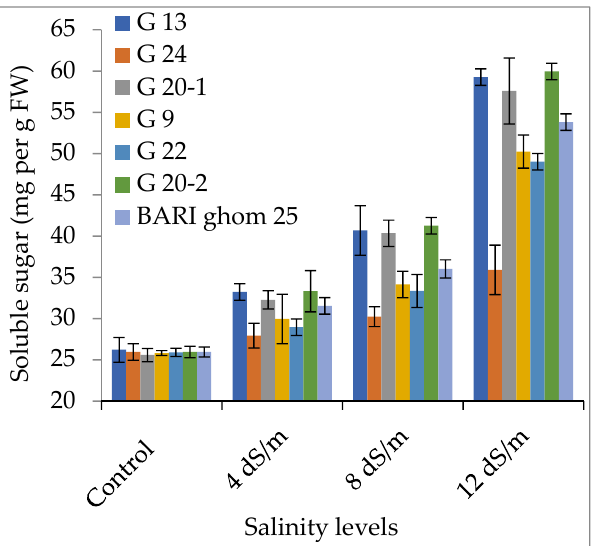
Figure 13. Soluble sugar content in leaf of wheat genotypes under various salinity levels. The vertical bar indicates average data of five independent replicates ( n = 5). Error bars represent standard error.